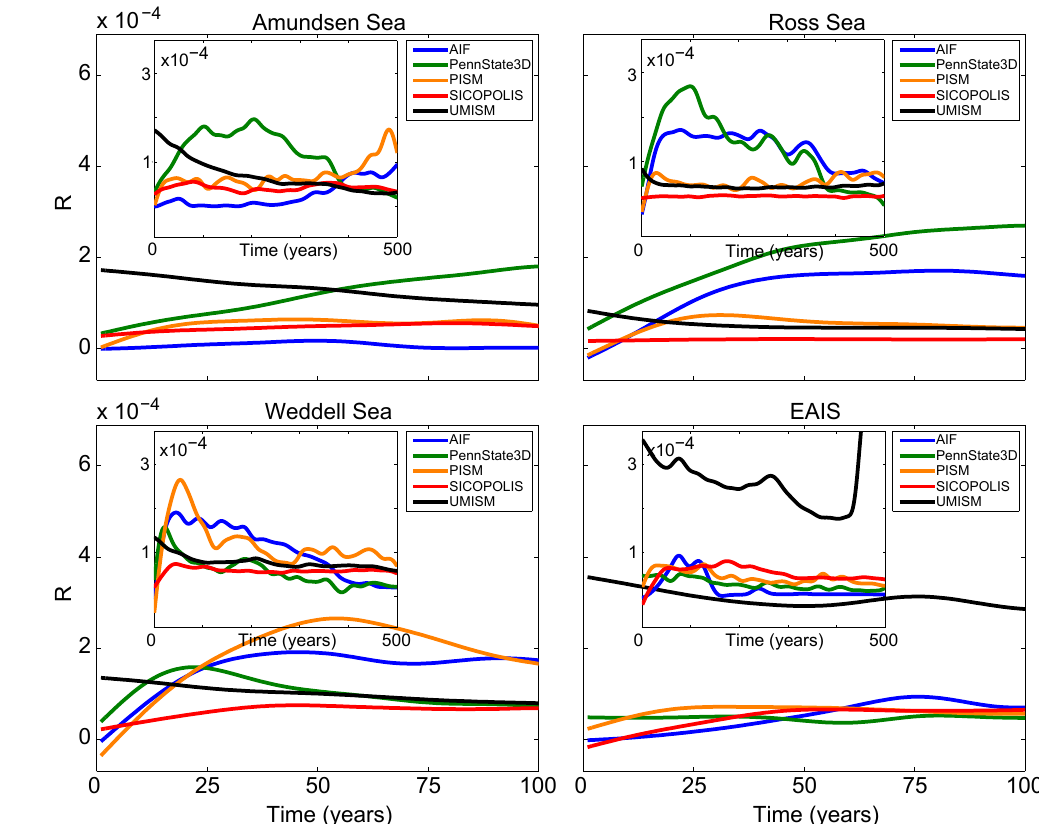
Figure 3. Linear response functions for the five ice-sheet models of Antarctica for each region as defined by Eq. (2) and as obtained from the SeaRISE-M2 experiments. The projections up to the year 2100, as computed here, will be dominated by the response functions up to year 100 since this is the period of the dominant forcing. For completeness, the inlay shows the response function for the full 500 years, i.e the period of the original SeaRISE experiments. As can be seen from Eq. (1), the response function is dimensionless. While the response functions are different for each individual basin and model when derived from the weaker M1 experiment (Fig. 14), the uncertainty range for the sea-level contribution in 2100 is very similar, since it is dominated by the uncertainty in the climatic forcing (compare Fig.